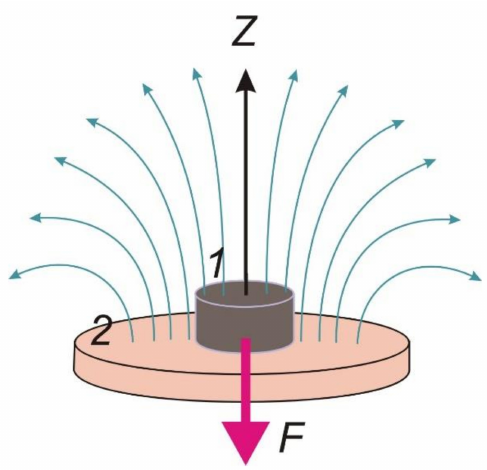
Figure 4. General sketch of the geometry of the considered measuring system: 1 —ferrogel sample; 2 —electromagnet. Small blue arrows illustrate the distribution of the magnetic field lines and the big magenta arrow shows the direction of the force F orientation.